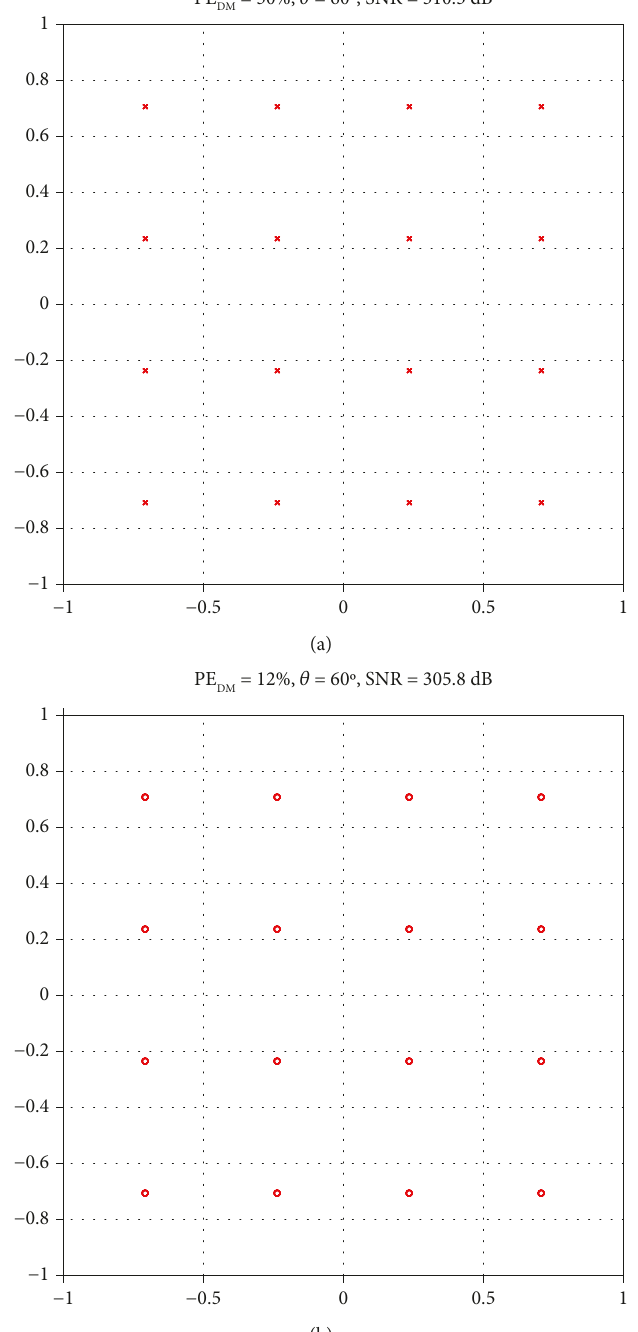
21 mn in the vector